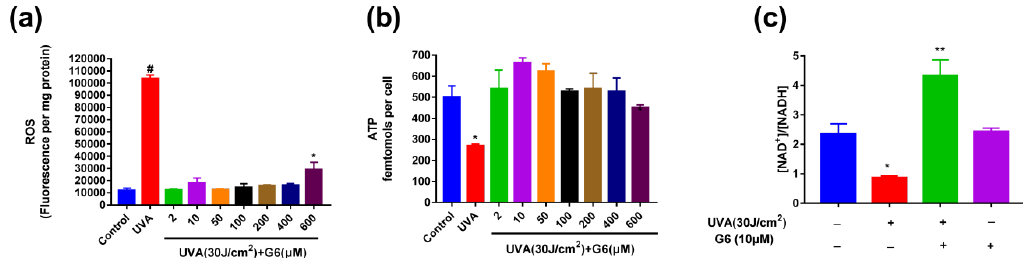
Figure 5. Effect of G6 on ROS production, ATP content, and NAD + /NADH ratio change. ( a ) The reactive oxygen species (ROS) production assay using 2 μM MCFH2-DA probe; ( b ) the ATP content; ( c ) the NAD + /NADH ratio change. The values are presented as the means ± S.E.M from at least nine independent experiments. Significant difference from control group: * p < 0.05, ** p < 0.01 and # p < 0.0001.